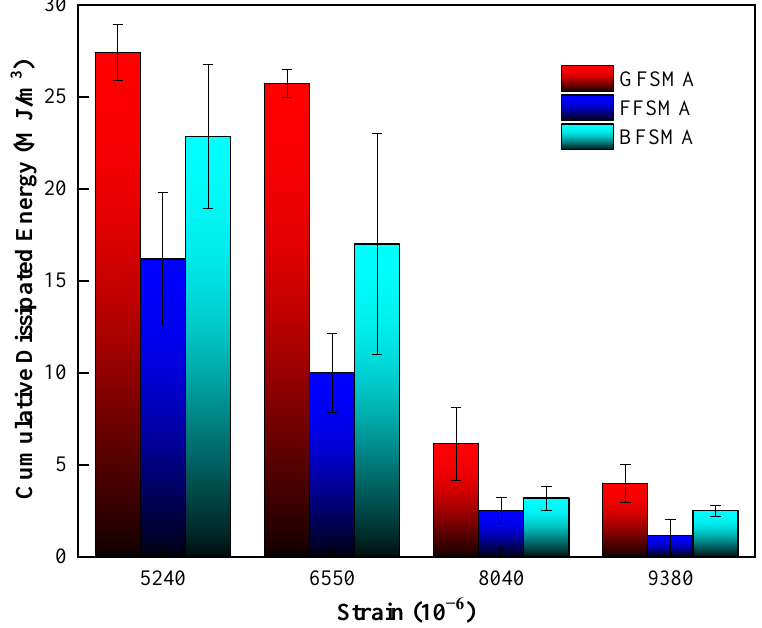
Figure 14. Cumulative dissipated energy results of